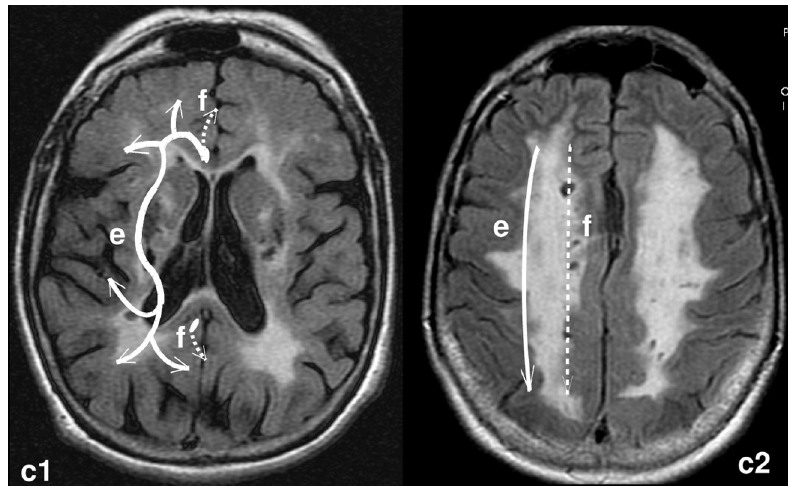
Figure 3. RM-FLAIR. Axial sections of the brain of a case with extensive subcortical de- myelination. The cholinergic pathways are depicted to the left side (medial path= white -interrupted, lateral path=white continu- ous) on two levels (similar to Figure